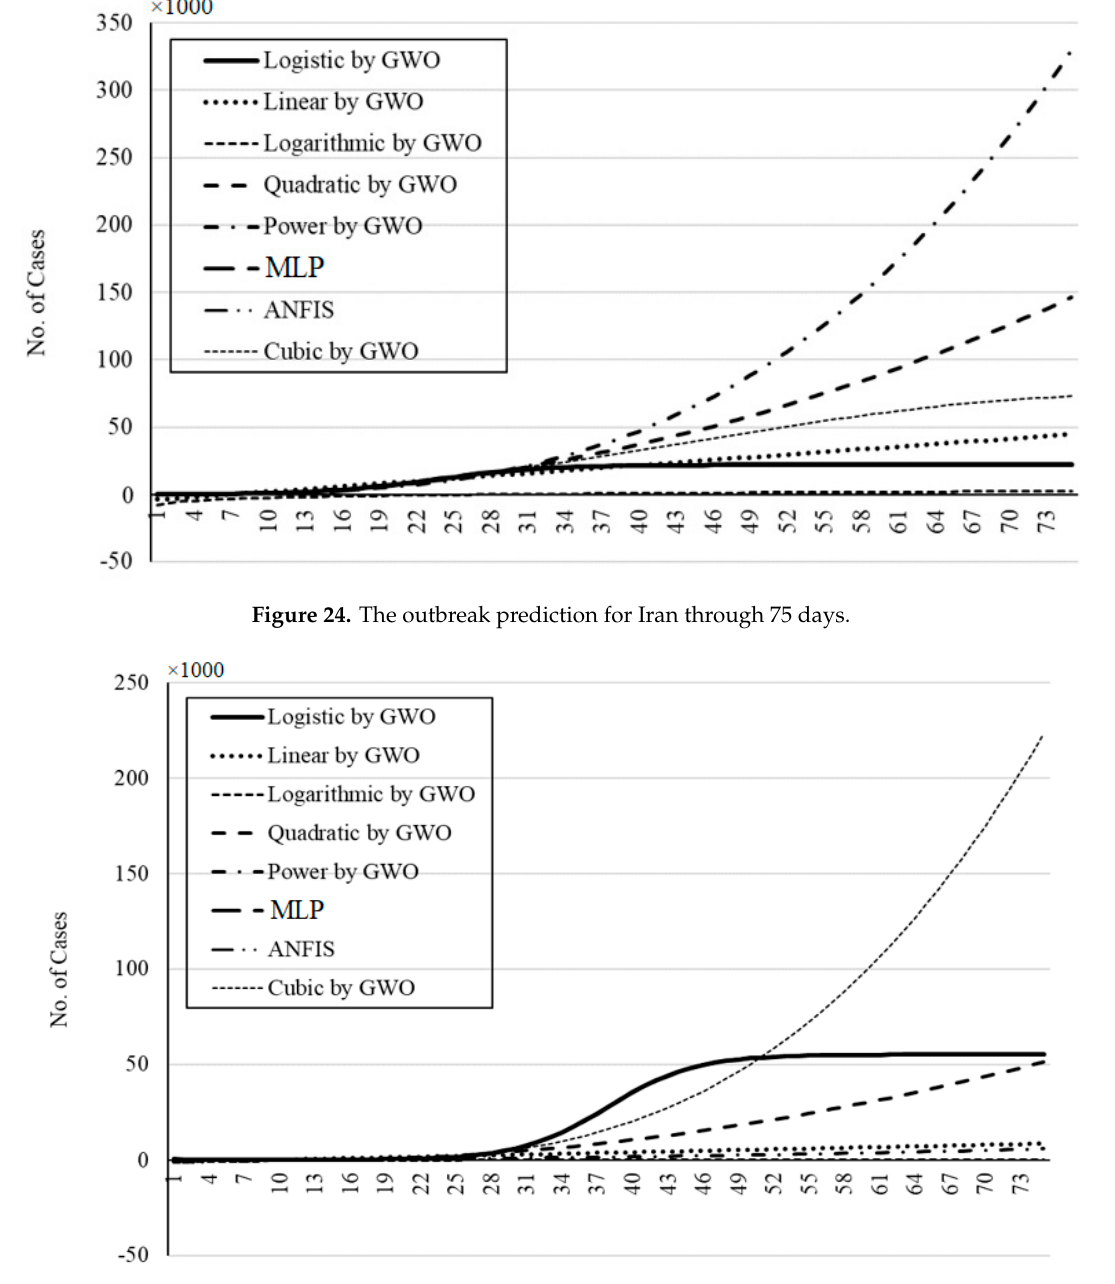
Figure 25. The outbreak prediction for Germany through 75 days.